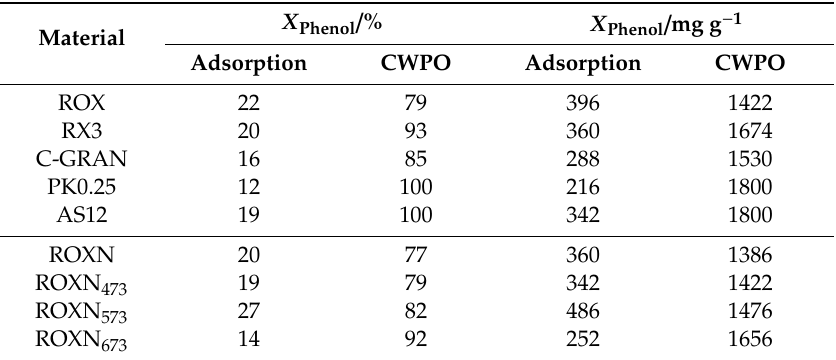
Table 3. Removals of phenol ( X Phenol ) obtained after 24 h in adsorption and catalytic wet peroxide oxidation (CWPO) runs performed with the AC samples, with [phenol] = 4.5 g L − 1 , [adsorbent / catalyst] = 2.5 g L − 1 , T = 353 K and pH =